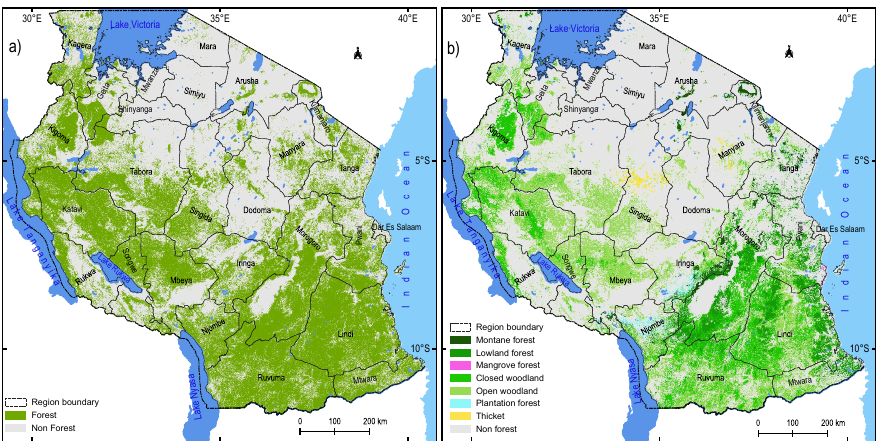
Figure 5. Map showing estimated areal proportional from the classification result: ( a ) forest/non- forest and ( b ) forest types in